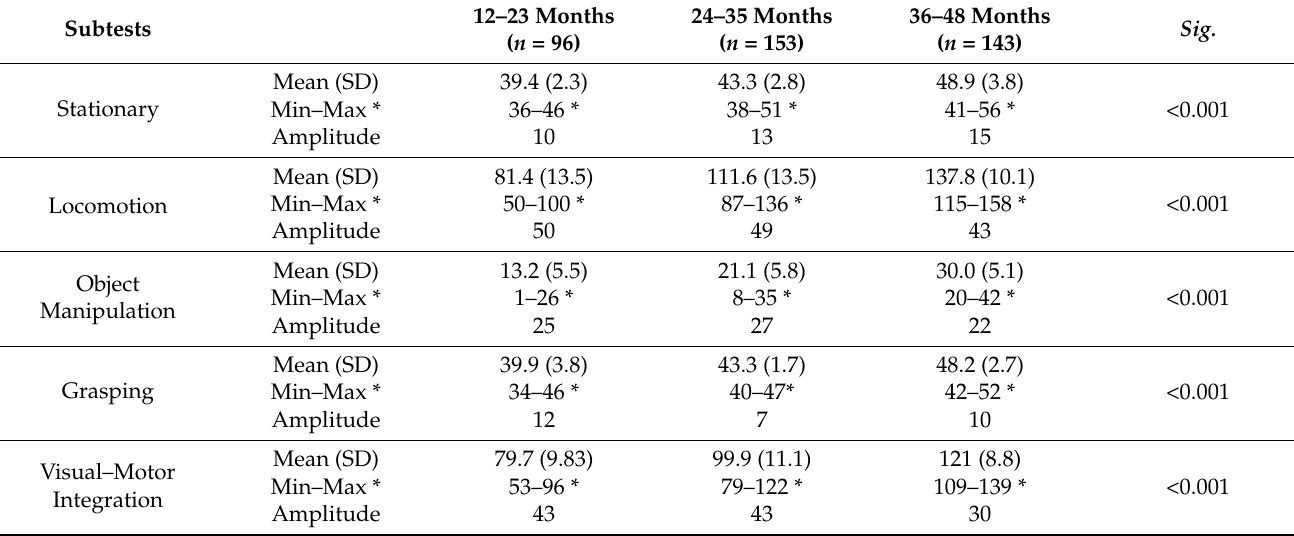
Table 2. Mean, standard deviation (SD), minimum-maximum value, amplitude of the Raw scores and comparison between groups, obtained in the sub-tests by age